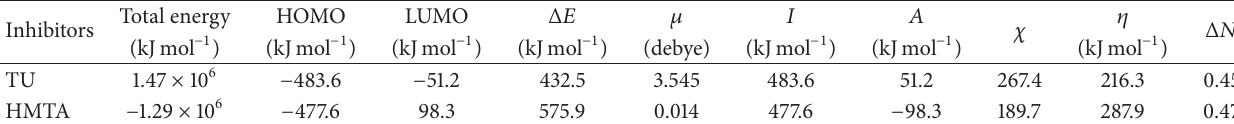
Table 4: Quantum chemical parameters derived for different inhibitors.